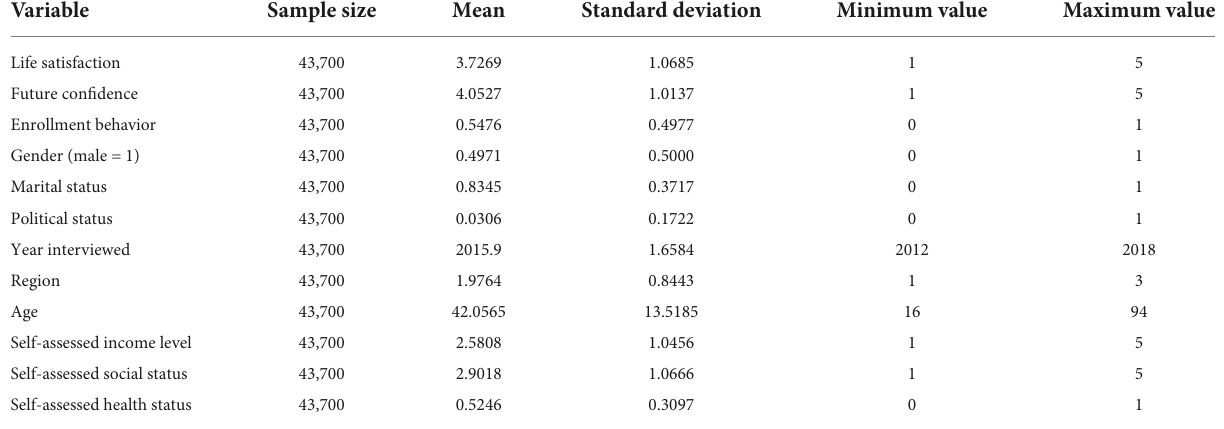
TABLE 2 Descriptive statistic results of